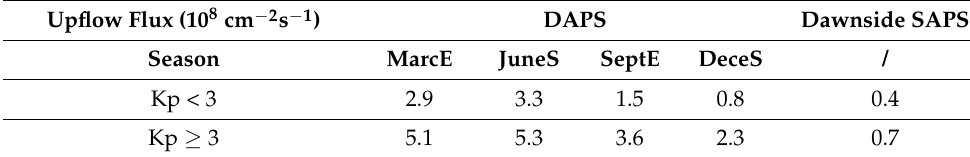
Figure 8. Superposed epoch analyses of the ion upward flux for DAPS ( a , b ) at March equinox and dawnside SAPS events ( c , d ) without seasonal separation under different geomagnetic activity levels. The 0 key MLat denotes the latitude where the cross-track velocity peaks. The bars show the mean standard deviations of 2 ◦ averages. Table 5. The mean ion upward flux at the latitudes where the DAPS and dawnside SAPS peak under two different Kp levels. The abbreviation MarcE denotes the March equinox, JuneS denotes the June solstice, SeptE denotes the September equinox, and DeceS denotes the December solstice.